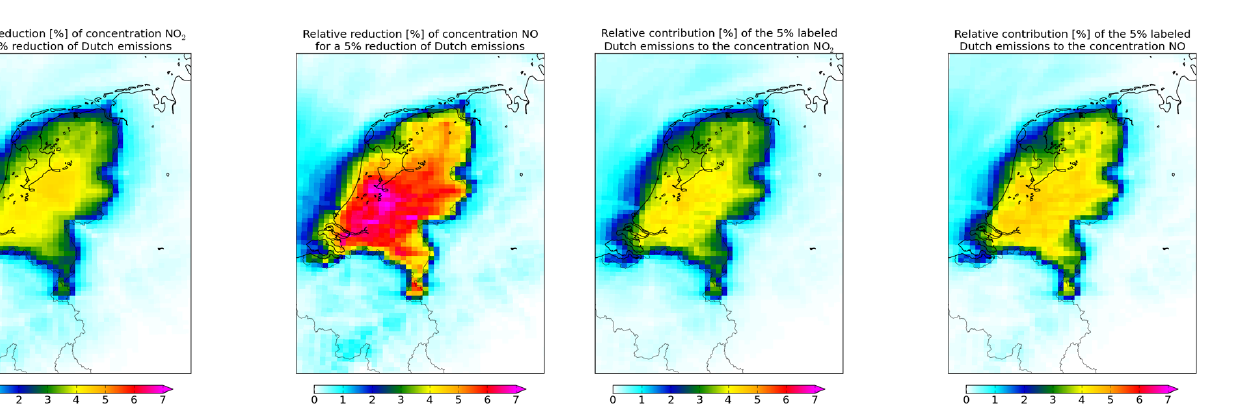
Fig. 5. Relative reduction of concentration NO 2 (left) and NO (right) by a reduction of 5% of the Dutch emissions. These sim- ulations are valid for the month July of 2006.